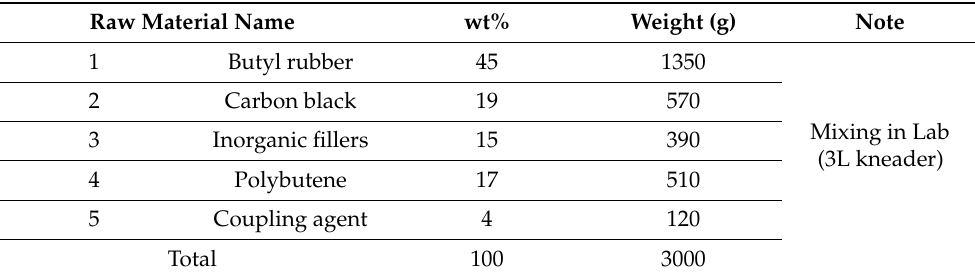
Table 2. Selection of basic mixing ratio.